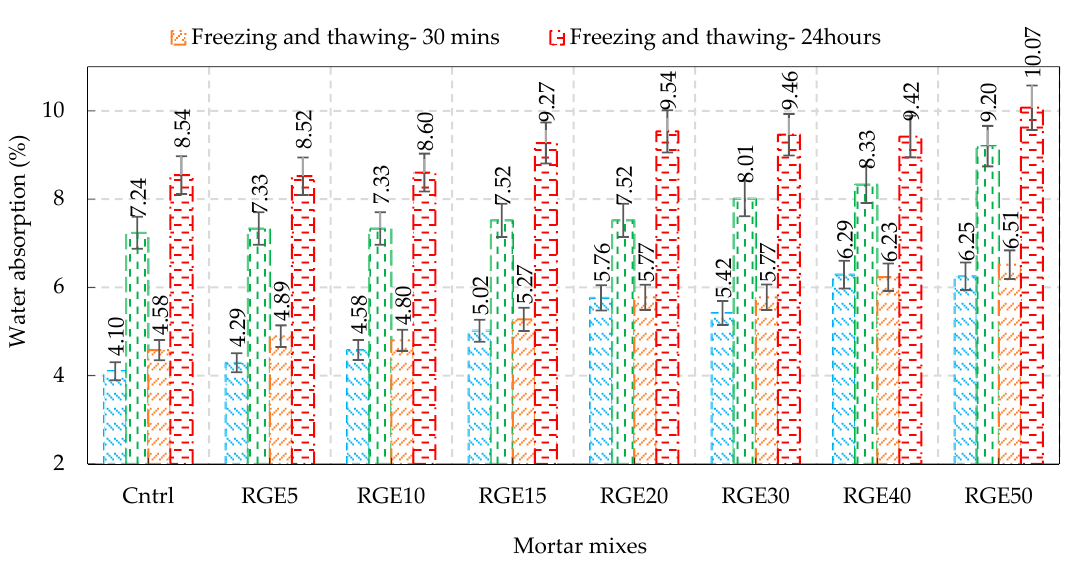
Figure 12. Water absorption of specimens in tap water and exposed to freeze–thaw cycles, at 28 days.